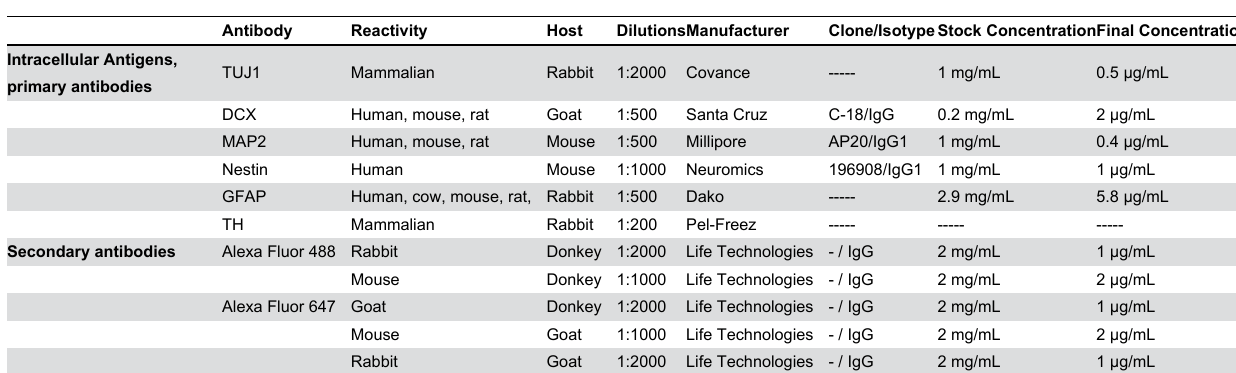
Table 1. Compilation of intracellular primary and secondary antibodies used, including optimized dilutions and